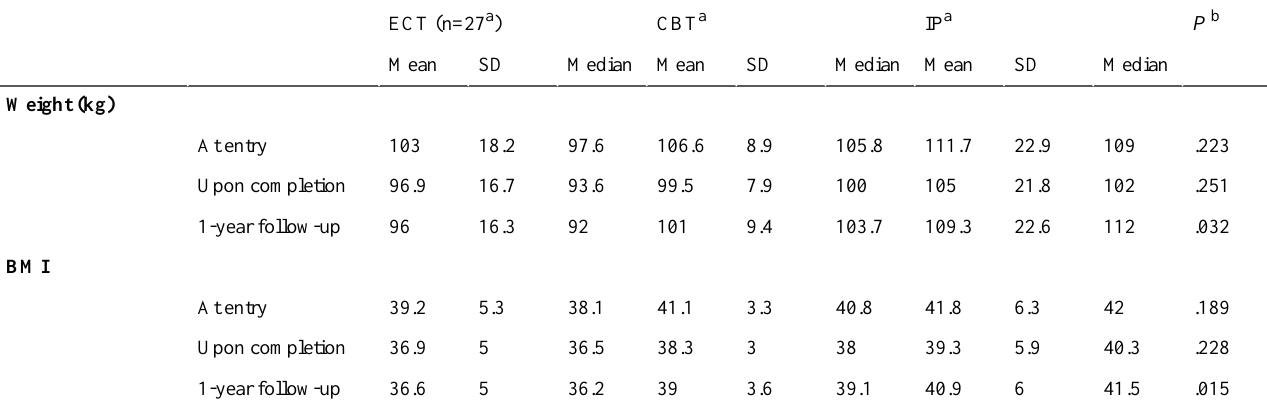
Table 4. Means, standard deviations, and medians for weight and BMI at entry of the study, upon completion of the inpatient program, and at 1-year follow-up by